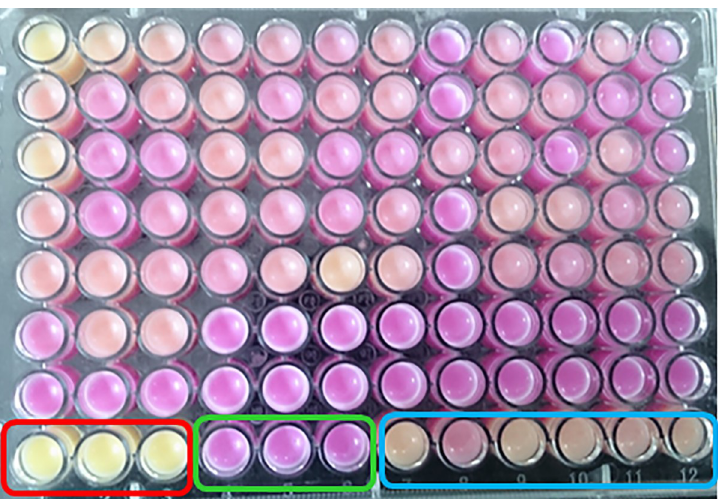
Fig 4. Change of pH due to hydrolysis of triglyceride by mutants of GTL indicated by phenol red. Wells in red rectangle are positive controls (pH < 6, without lipase), in green rectangle are negative controls (pH 9.5, without any lipase) and in blue rectangle are with GTL. Acidic samples are yellow in colour (due to activity of lipase) and alkaline samples are purple in colour.